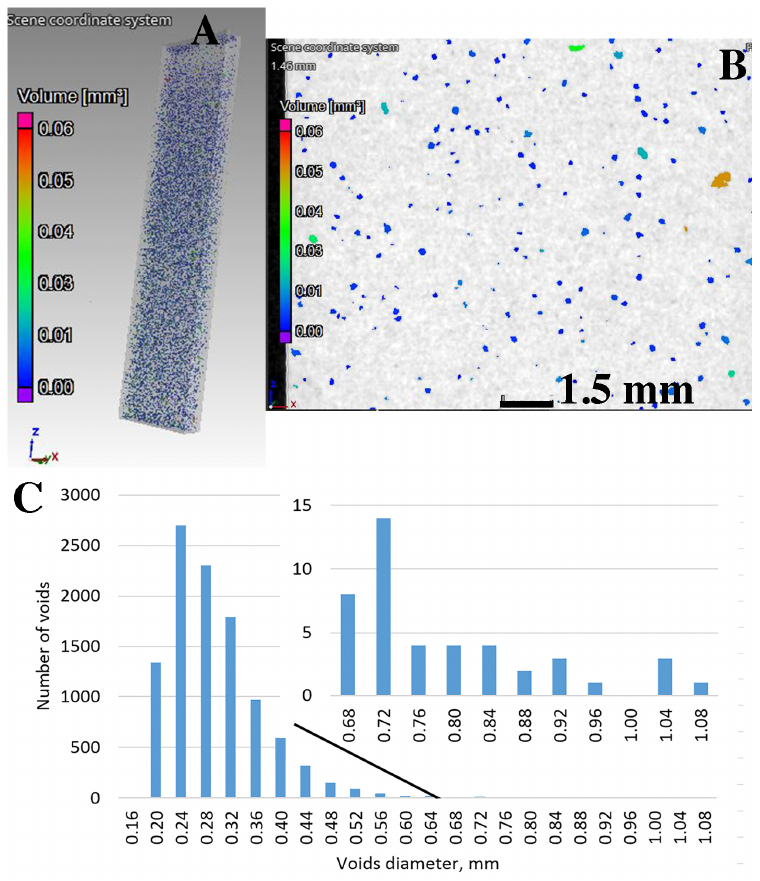
Figure 7. The results of CT tests of samples made of AlSi10Mg-cast: ( A ) sample 3D model, ( B ) porosity in cross-section and ( C ) diameter and volume distribution of separate pores.